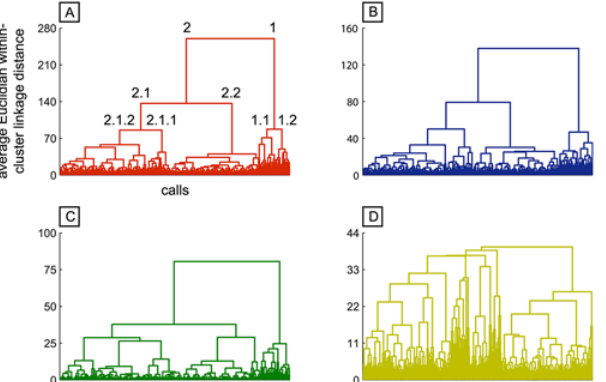
Fig 2. Unsupervised Ward ’ s clustering of 912 chacma baboon calls based on different frequency dependent and temporal feature setups. The x-axis represents groups of calls, and the y-axis represents average Euclidian within-cluster linkage distance. (A) Set consisting of 118 features. High-frequency (cluster 1) and low-frequency (cluster 2) were segregated into two first-order clusters. High frequency calls further subdivide into more tonal (cluster 1.1) and relatively noisier (cluster 1.2) calls. Low frequency calls subdivide into short and very low-frequency grunt-calls (cluster 2.2), moderate-frequency and harmonic weaning-calls (cluster 2.1.1), and more noisy, short bark-calls (cluster 2.1.2). (B) Set consisting of 38 features. (C) Set consisting of 9 features. (D) Set consisting of 19 factors determined by factor